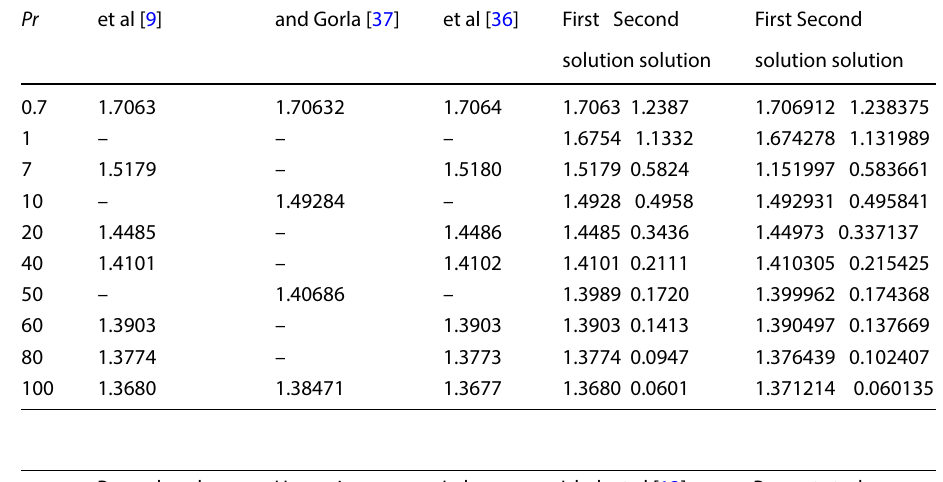
Table 4 For different Pr the values of − 𝜃 � ( 𝜉 ,0 ) with 𝜆 =1